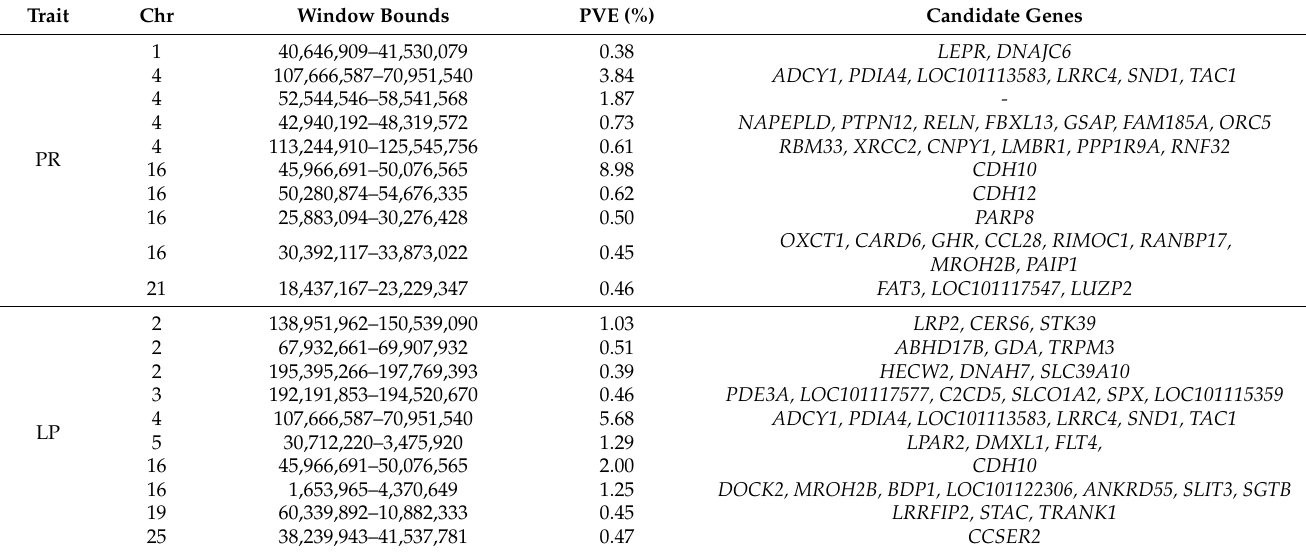
Table 4. Chromosome, location, proportion of additive genetic variance (PVE, %) and candidate genes within the top 10 windows associated with the pregnancy rate (PR) and lambing potential (LP) of Merino